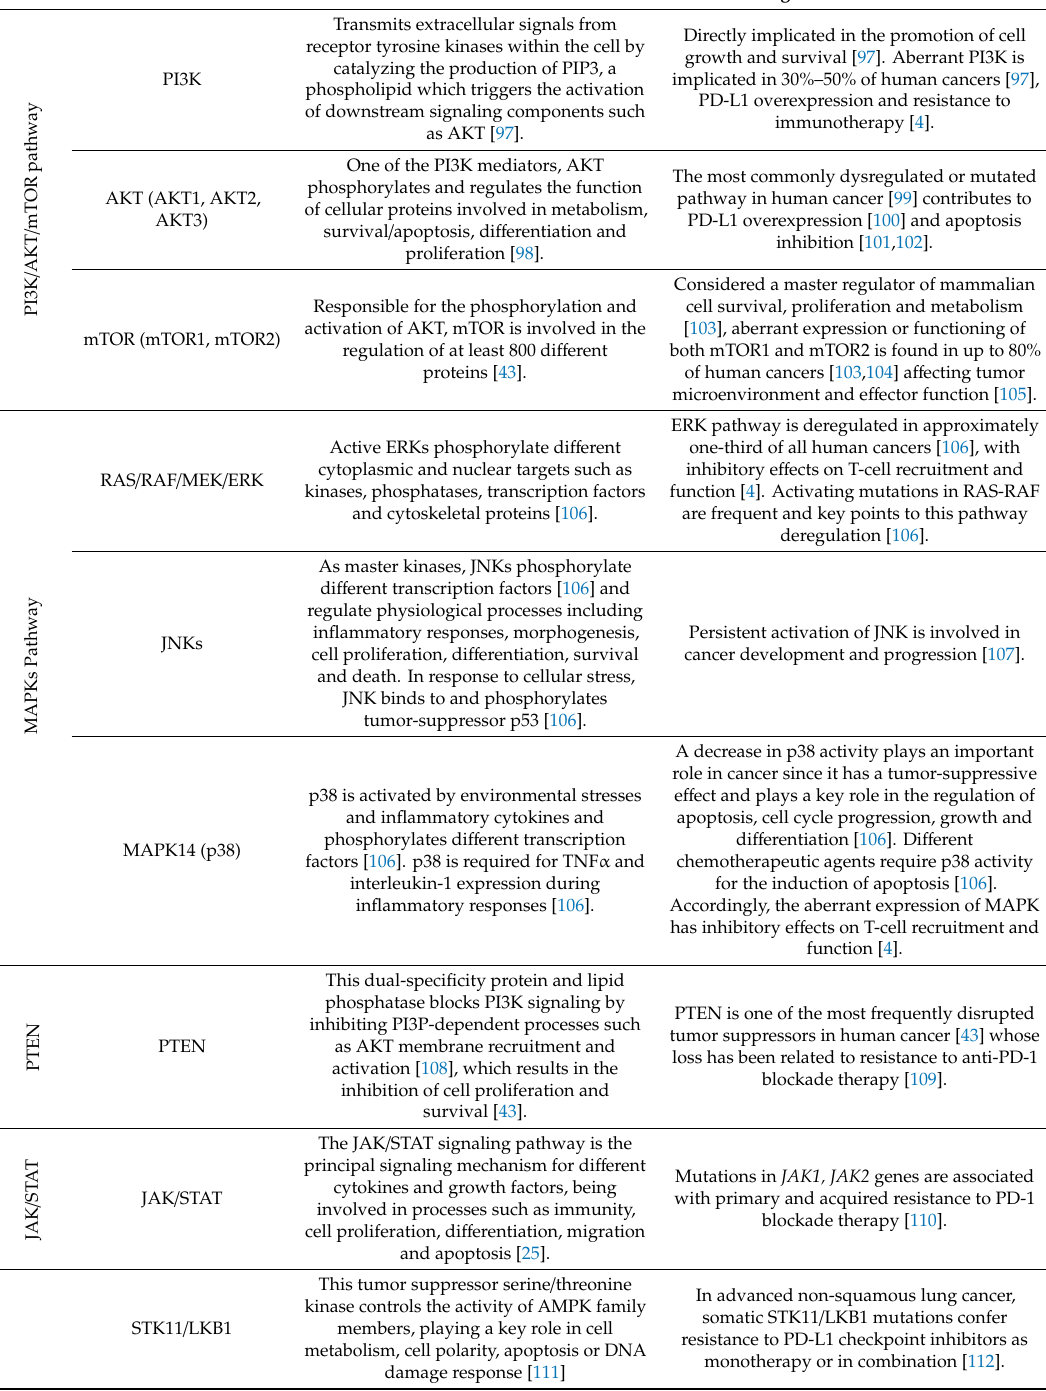
Table 3. Main non-receptor kinases related to apoptosis inhibition in human cancer. Kinase Overview Significance in Cancer